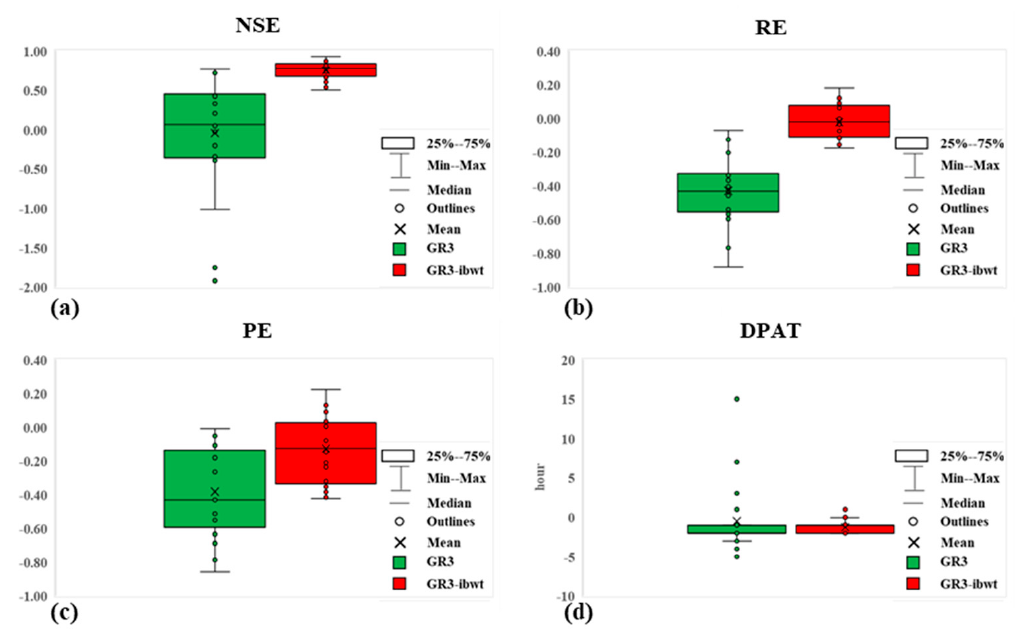
Figure 9. Box diagram of the measured and simulated discharge evaluation in flood processes. ( a ) is the box diagram of NSE; ( b ) is the box diagram of RE; ( c ) is the box diagram of PE; ( d ) is the box diagram of DPAT.